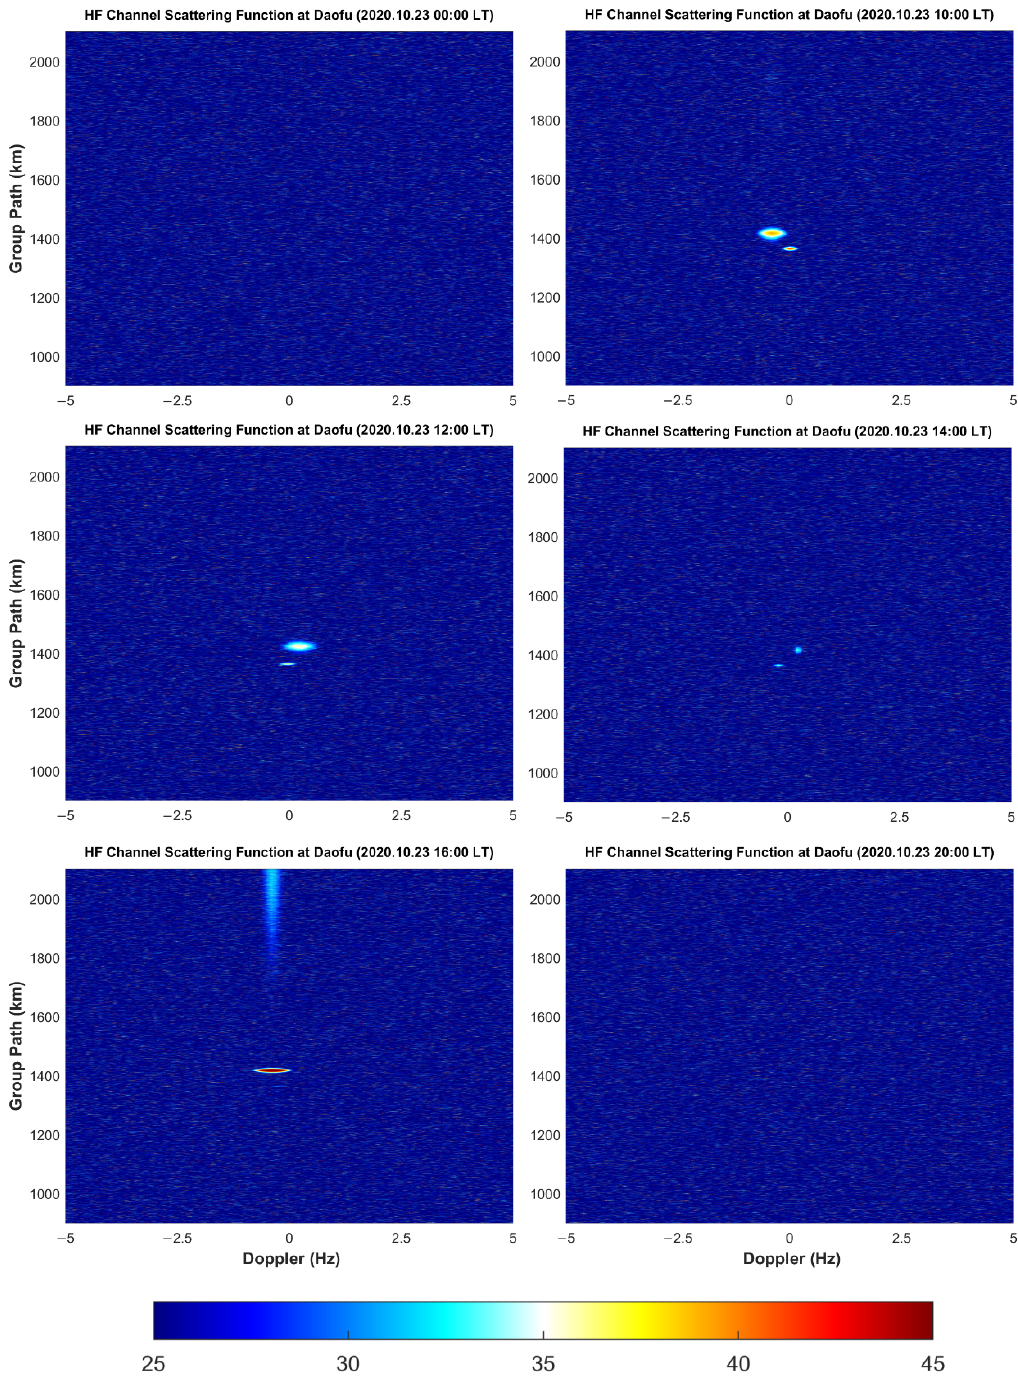
Figure 15. 23 October 2020, the modeling and simulation results of the HF channel at Daofu station. Refer to the captions in Figure 10 for the receiving time and other descriptions of each panel.